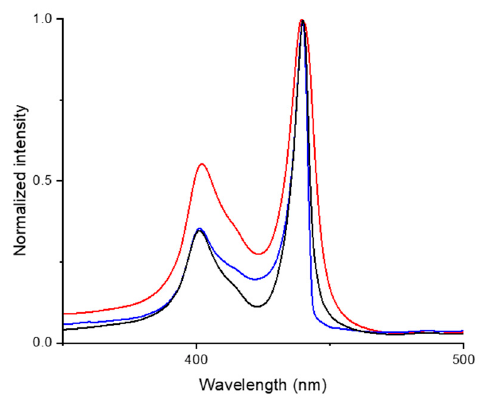
Figure 9. Normalized UV-Vis spectra of StarP water solution (red line), and of the StarP-F (blue line) and StarP-R (black line) solutions.